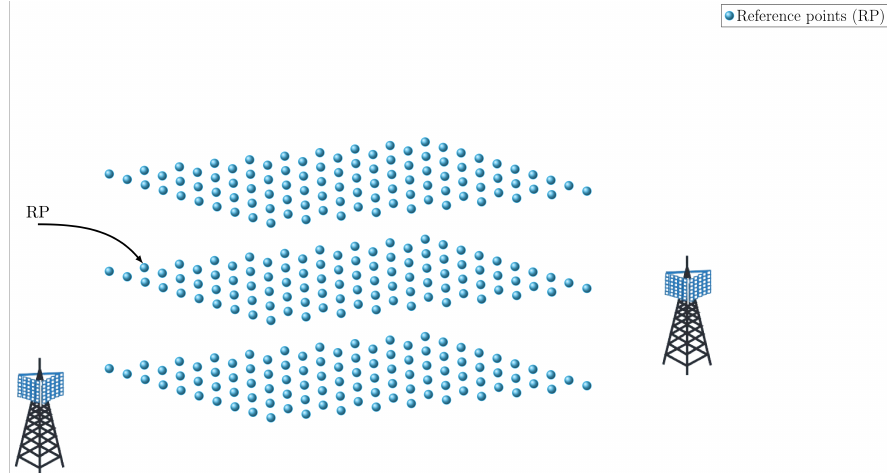
Figure 5. Reference points in